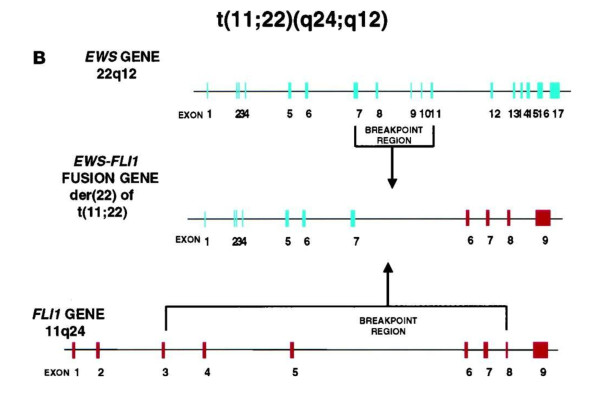
Diagram of t(11;22)(q24;q12) and the EWS-FLI1 gene fusion. Adapted from; Enrique de Alava, William L. Gerald, Biology of Sarcoma/Primitive Neuroectodermal Tumor Family, Journal of Clinical Oncology, Vol 18, Issue 1(January), 2000: 204.